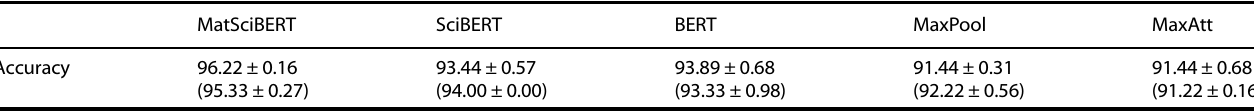
Table 4. Test set results for glass vs. non-glass dataset averaged over three seeds.